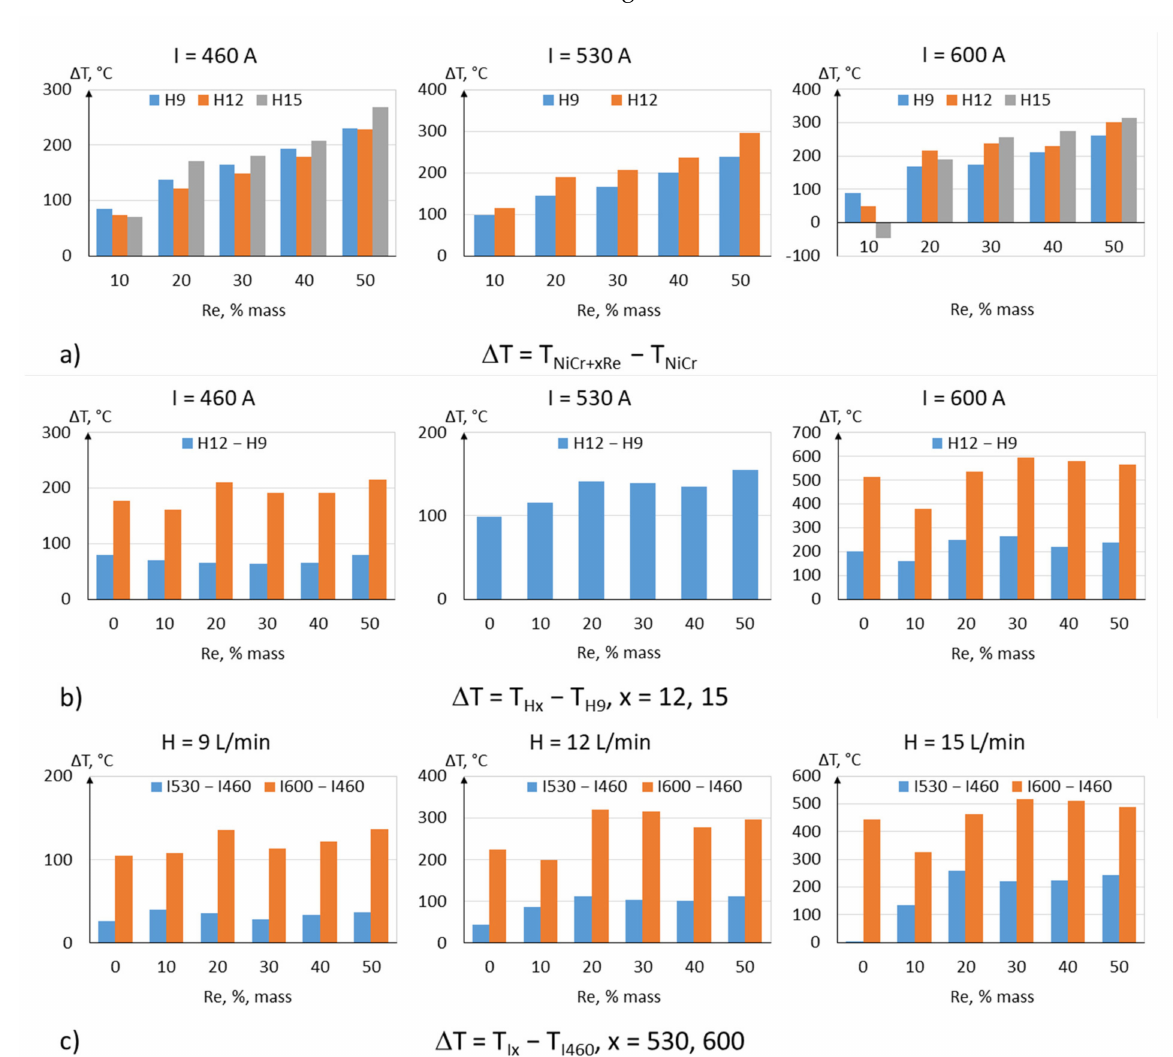
Figure 14. Changes in in-flight particle temperature ∆ T: ( a ) in relation to rhenium content, ( b ) in relation to hydrogen flowrate, and ( c ) in relation to current